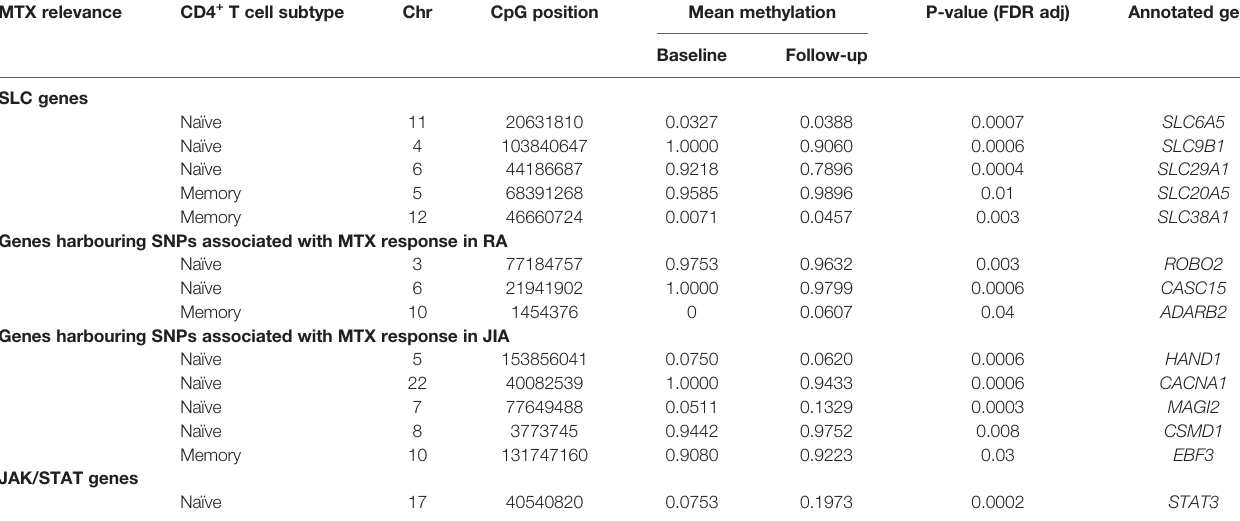
TABLE 2 | DMPs annotated to genes previously reported to be relevant to MTX function or treatment response in RA or